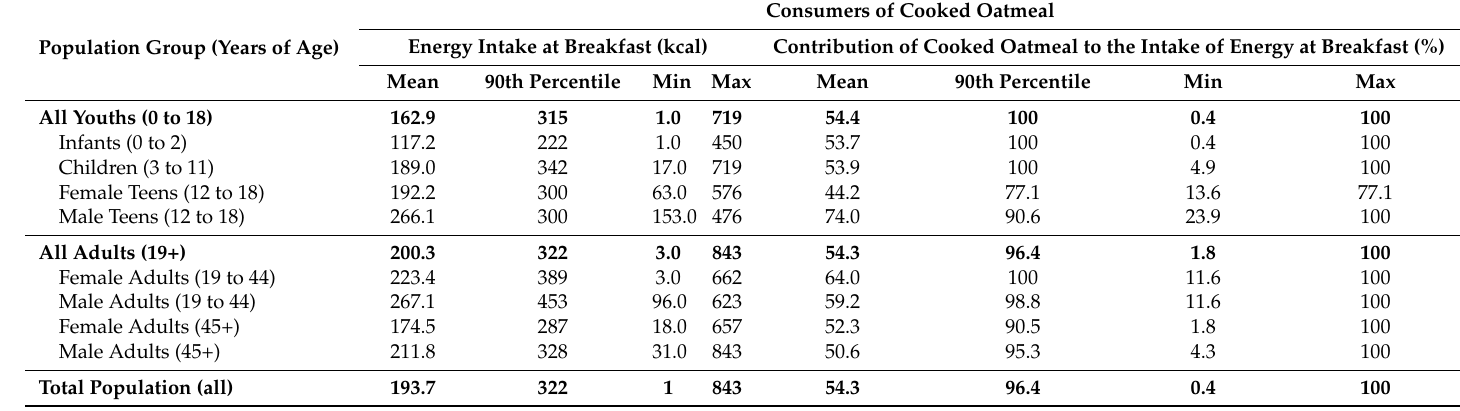
Table 4. The contribution of cooked oatmeal to the total intake of energy at breakfast in consumers of cooked oatmeal (data from Day 1 of the 2009–2012